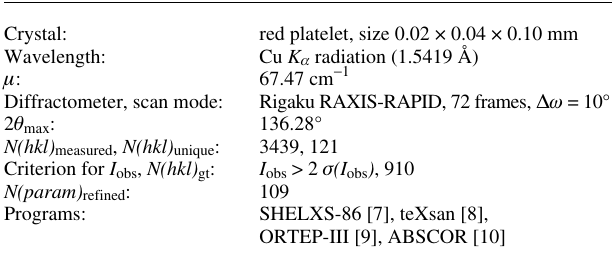
Table 1. Data collection and handling.